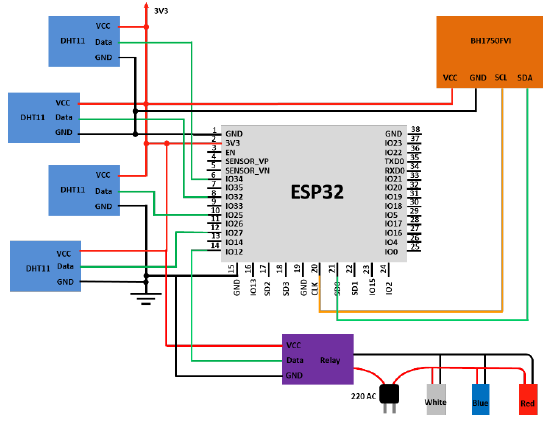
Figure 4. Circuit diagram.